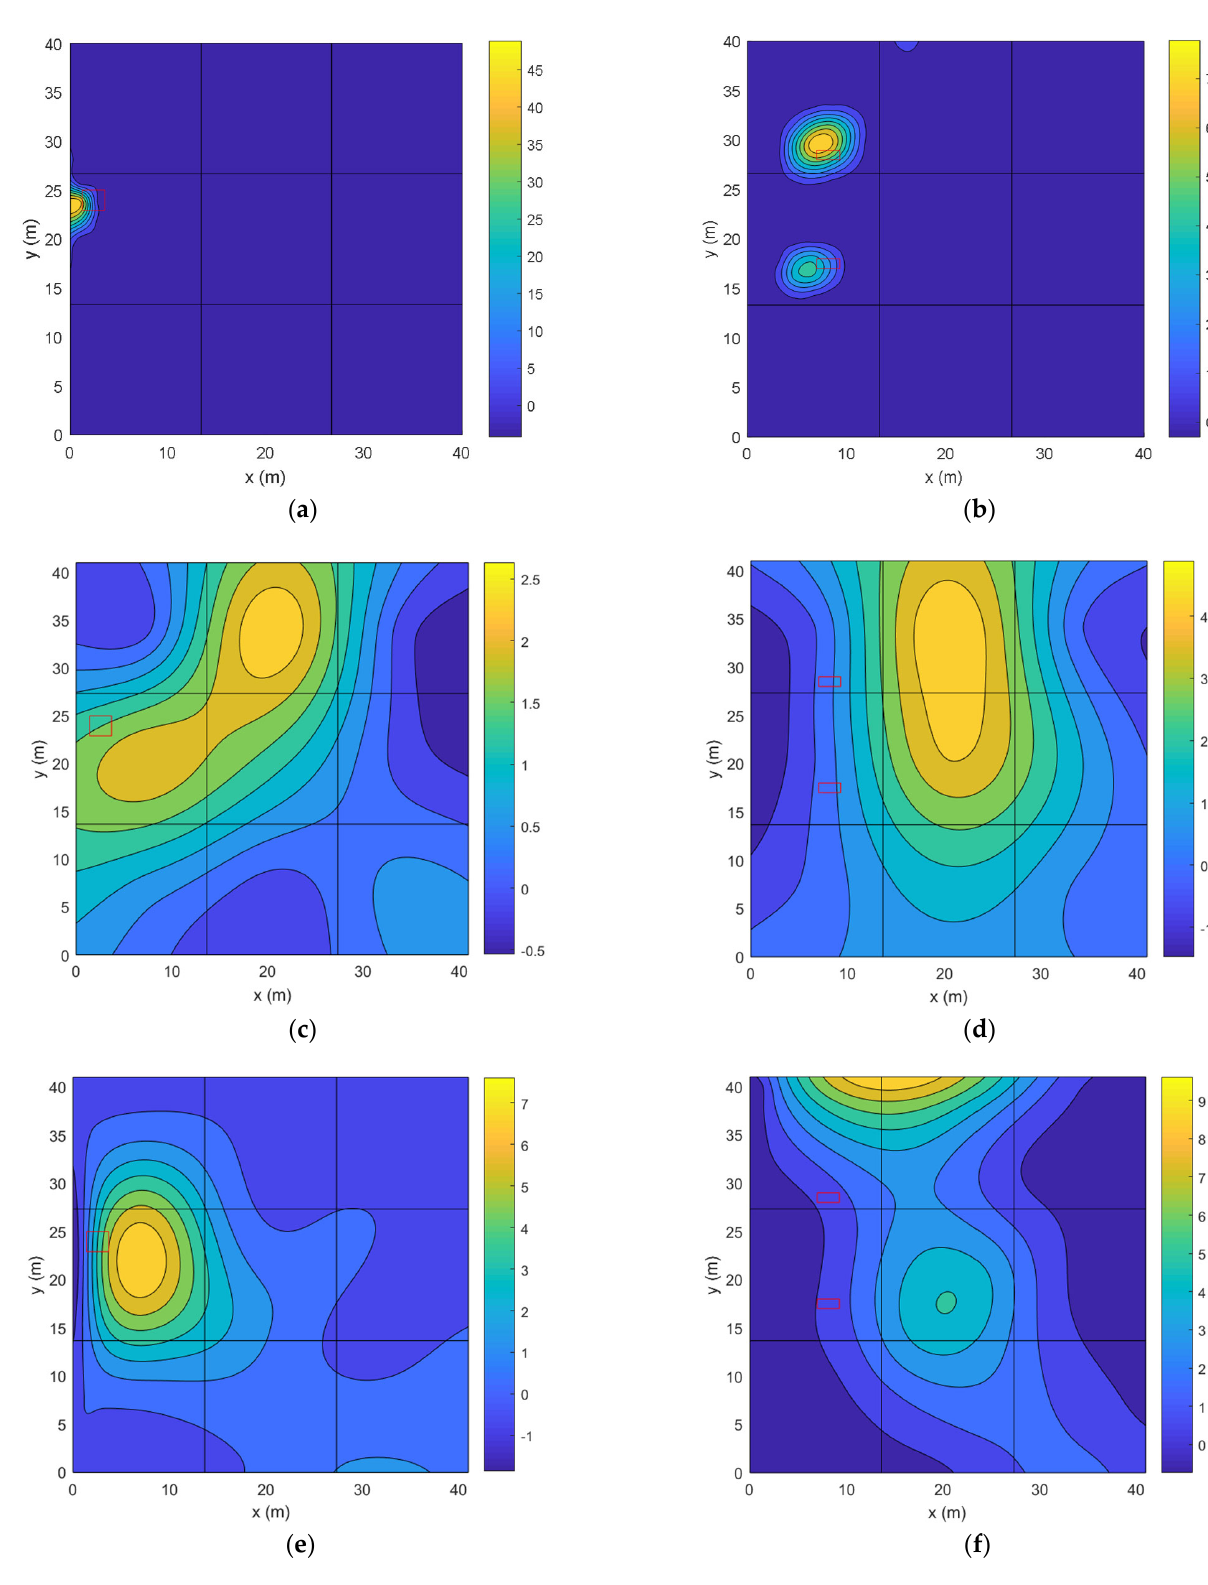
Figure 7. ( a , b ) Predicted emission distributions (unit: g/s.m 2 ); ( c , d ) predicted concentration maps using the NNLS algorithm (unit: g/m 3 ); and ( e , f ) predicted concentration maps using the MC algorithm (unit: g/m 3 ). The first column shows results for Release One. The second column shows results for Release Two. The rectangular areas are the real area sources. The black lines show 3 × 3 division for the beams.